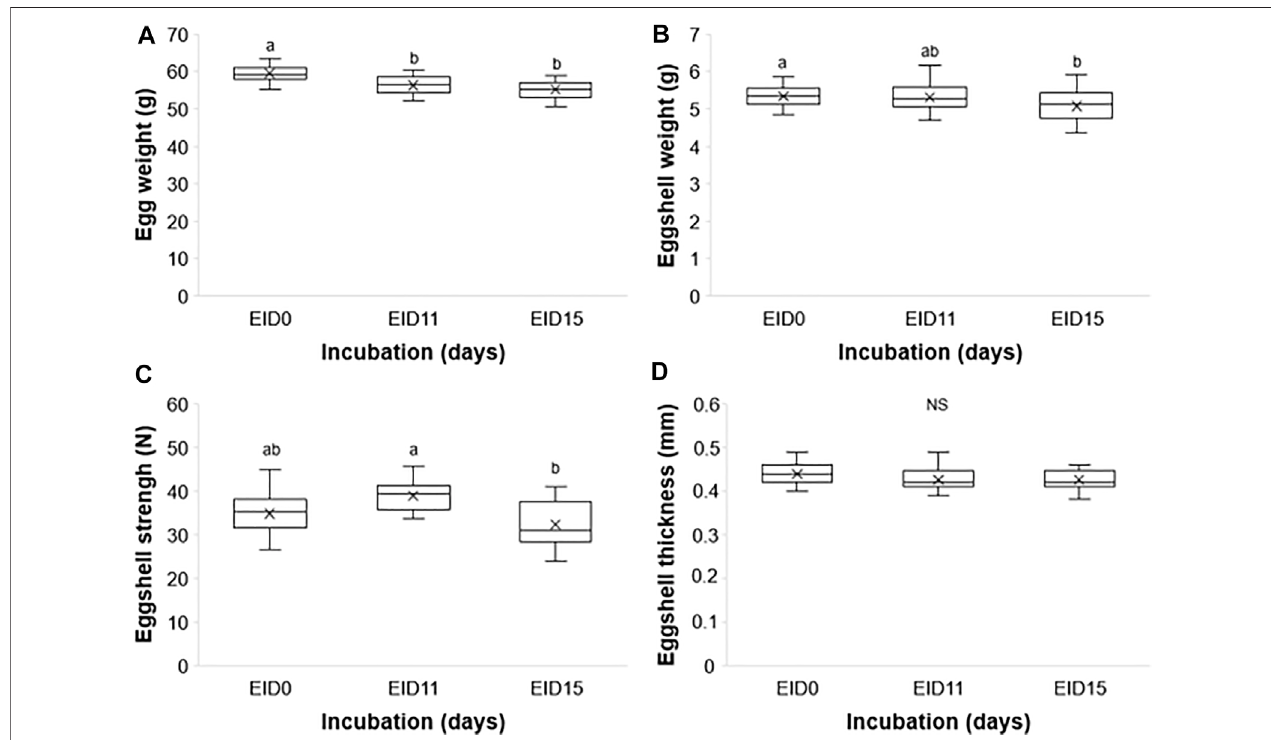
FIGURE 2 | Egg and ES characteristics at EID0, EID11, and EID15. (A) Egg weight. (B) ES weight. (C) ES breaking strength. (D) ES thickness. n = 30 per developmental stage. Different letters indicate values that are signi fi cantly different ( p < 0.05) between developmental stages EID0, EID11, and EID15.